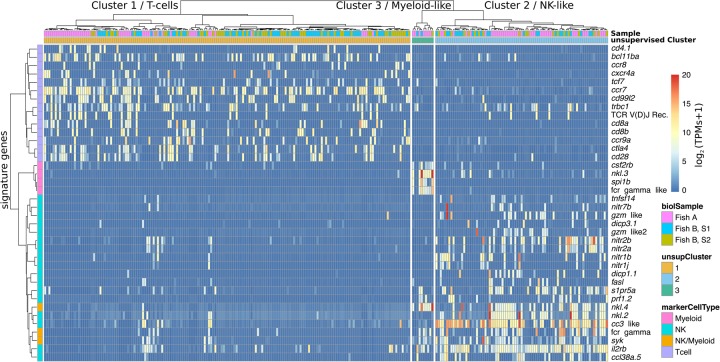
Heatmap showing the expression levels of important differentially expressed marker genes. Columns and rows represent cells and marker genes, respectively. Colors of the columns show the plates (top row) and the assigned clusters for each cell based on unsupervised whole-transcriptome clustering (second row; dendrogram shown on top). Colors of the rows (left-most column) indicate the known function of marker genes based on the literature (T-cell, NK, or myeloid marker). The heatmap color scale indicates the log2 TPMs (see Methods). Apart from a few cells in the T-cell cluster that show expression of NK markers, the unsupervised whole-transcriptome clustering is very well recapitulated by expression of known and putative cell-type markers.